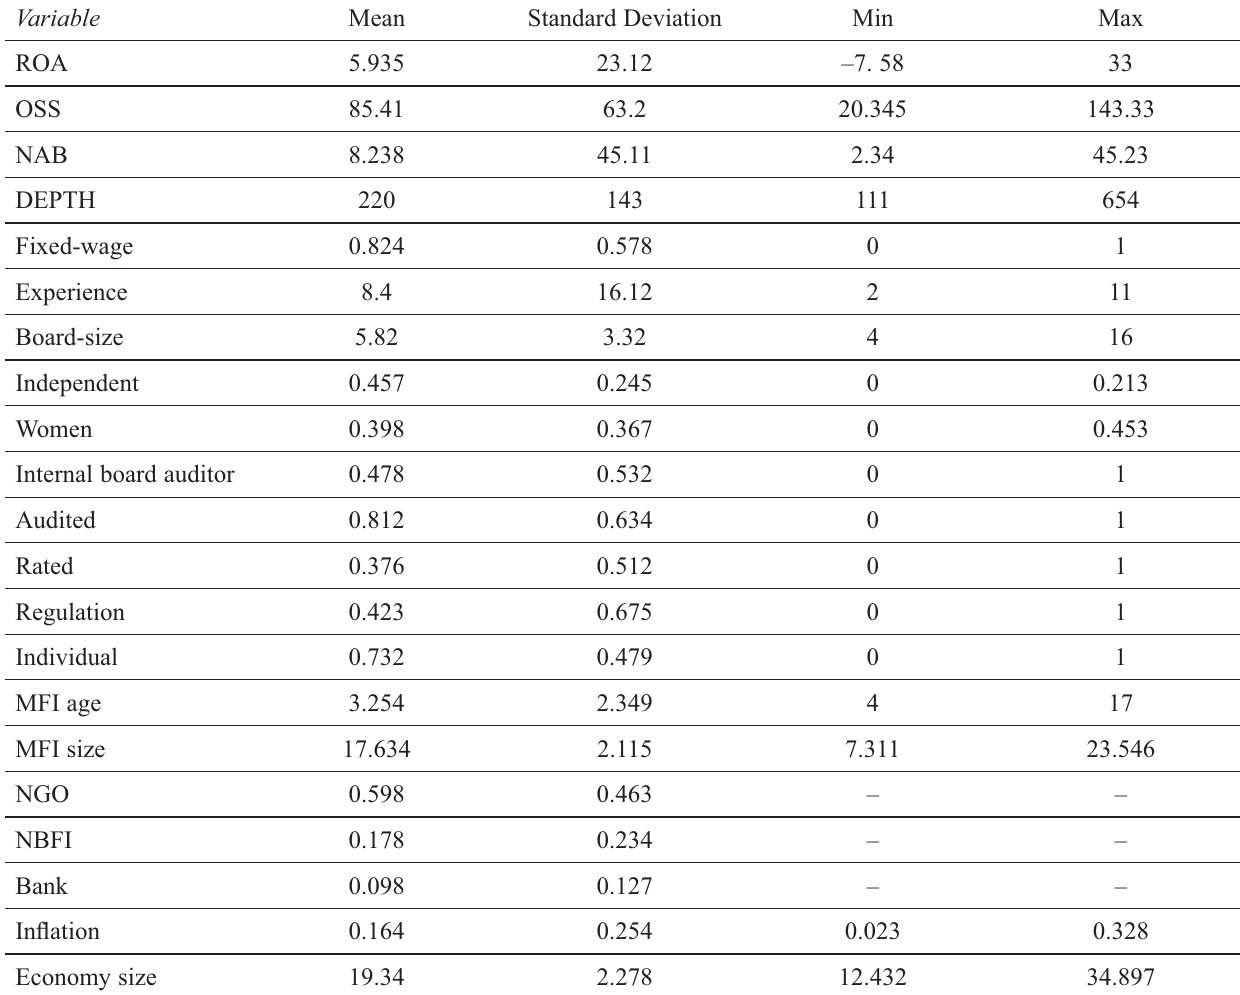
Table 3. Descriptive statistics (N =